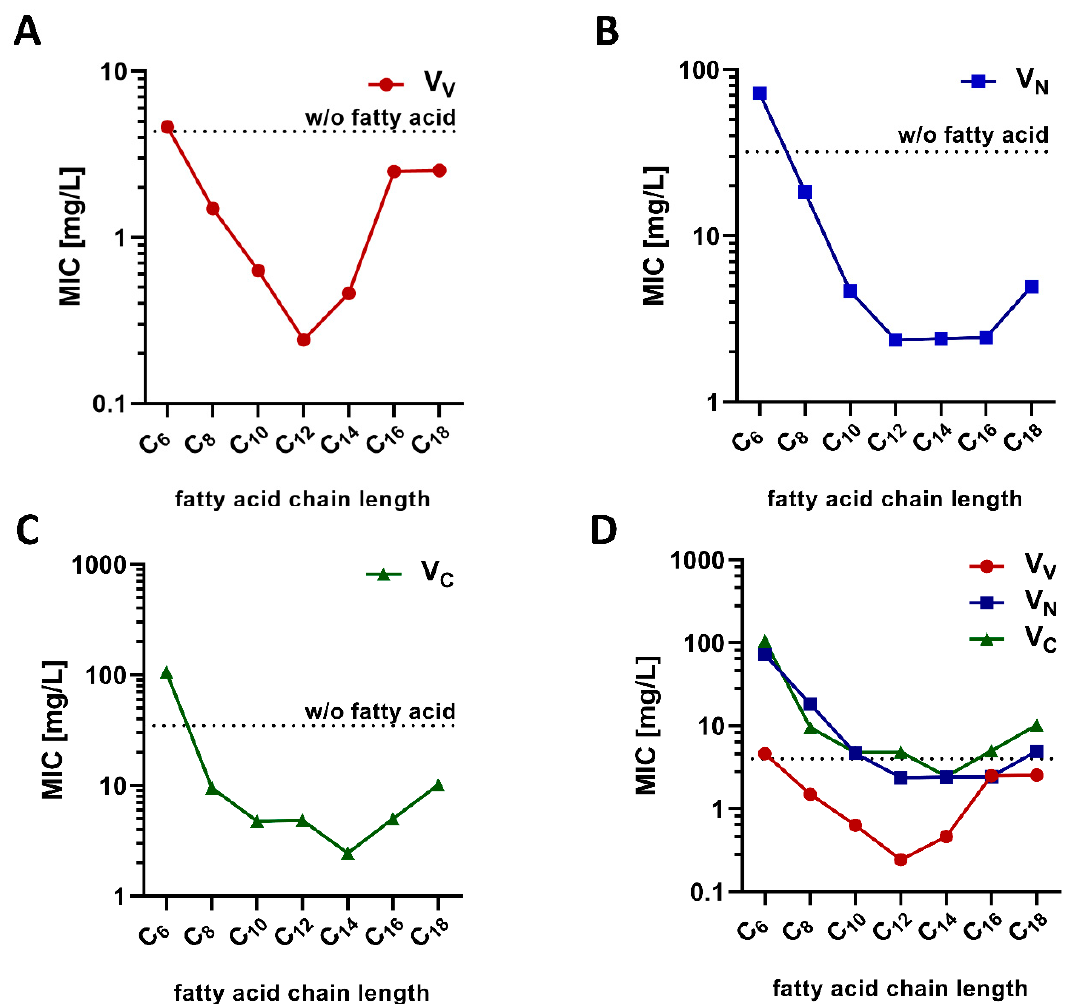
Figure 2. ( A – C ) Antimicrobial activity of vancomycin-lipopeptide conjugates (different modification sites) for a clinical isolate of Enterococcus faecium (UL602570). The dotted line indicates the minimum inhibitory concentration (MIC) of the respective conjugate modified only with the peptide sequence. ( D ) Comparison of all three modification sites. The dotted line represents the enterococci resistance breakpoint. Data are shown as the median of a minimum of three independent experiments tested at least in duplicate. A tabular overview is shown in the supplementary information, Table S1.